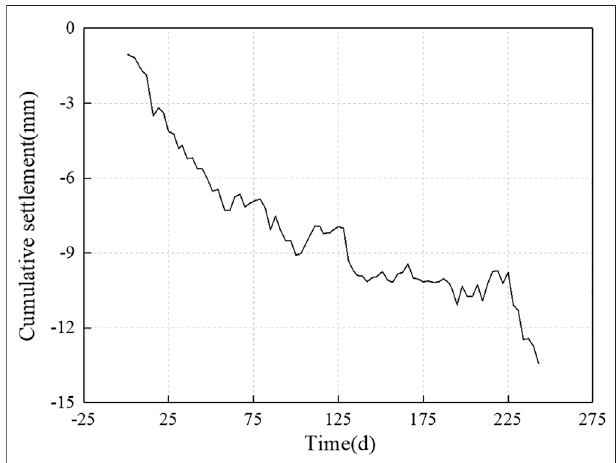
FIGURE 7 | Data change curve in the fi rst